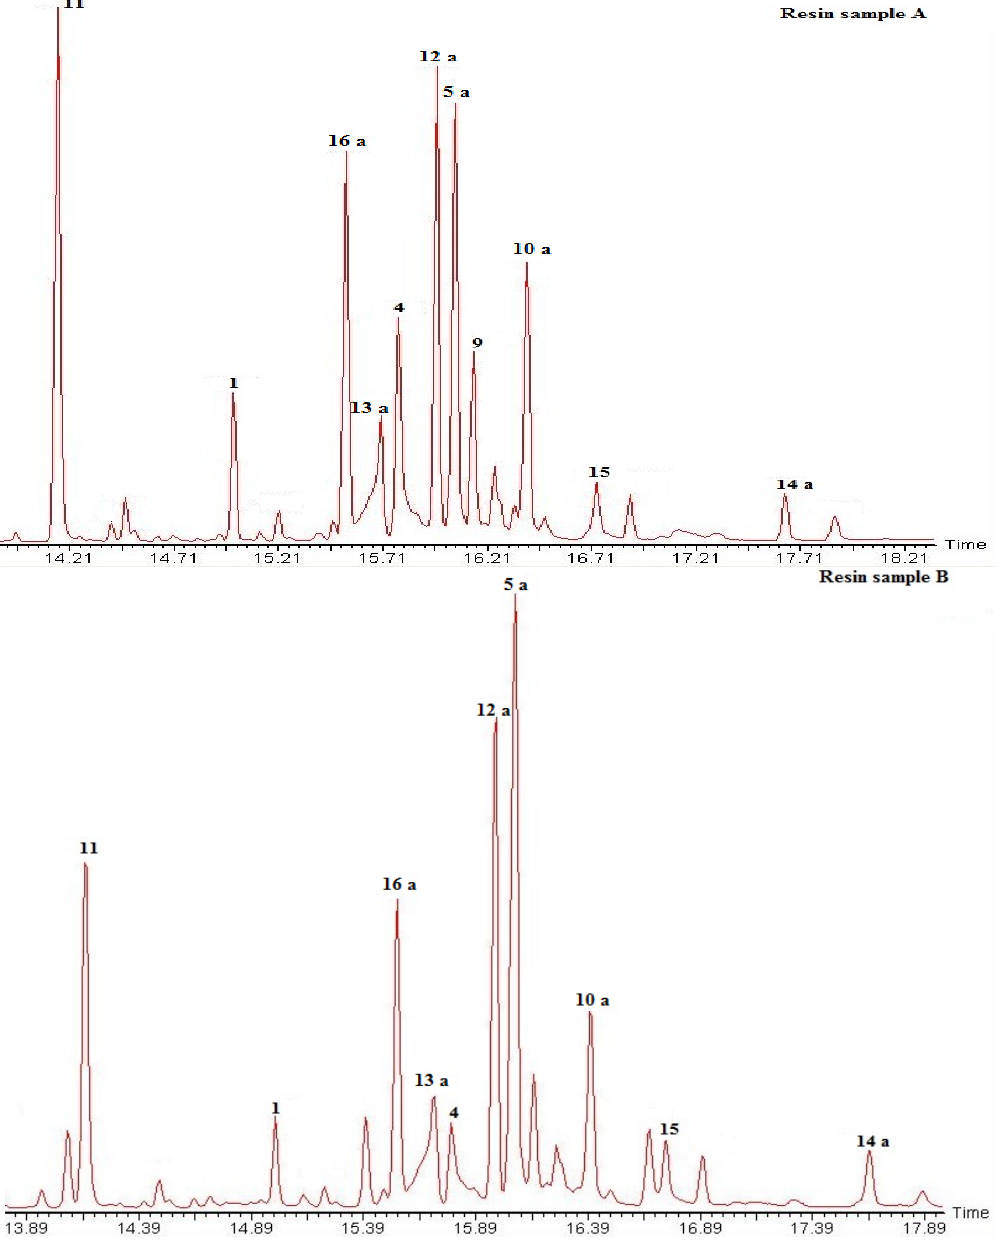
ester. For compounds 6 , 9 and 10 , M + -water was detected instead of the molecular ion. The resin sample A was obtained from a female tree while the sample B was taken from a male tree from the same population. Both samples were collected in November 2010. For compound structures please see Figure